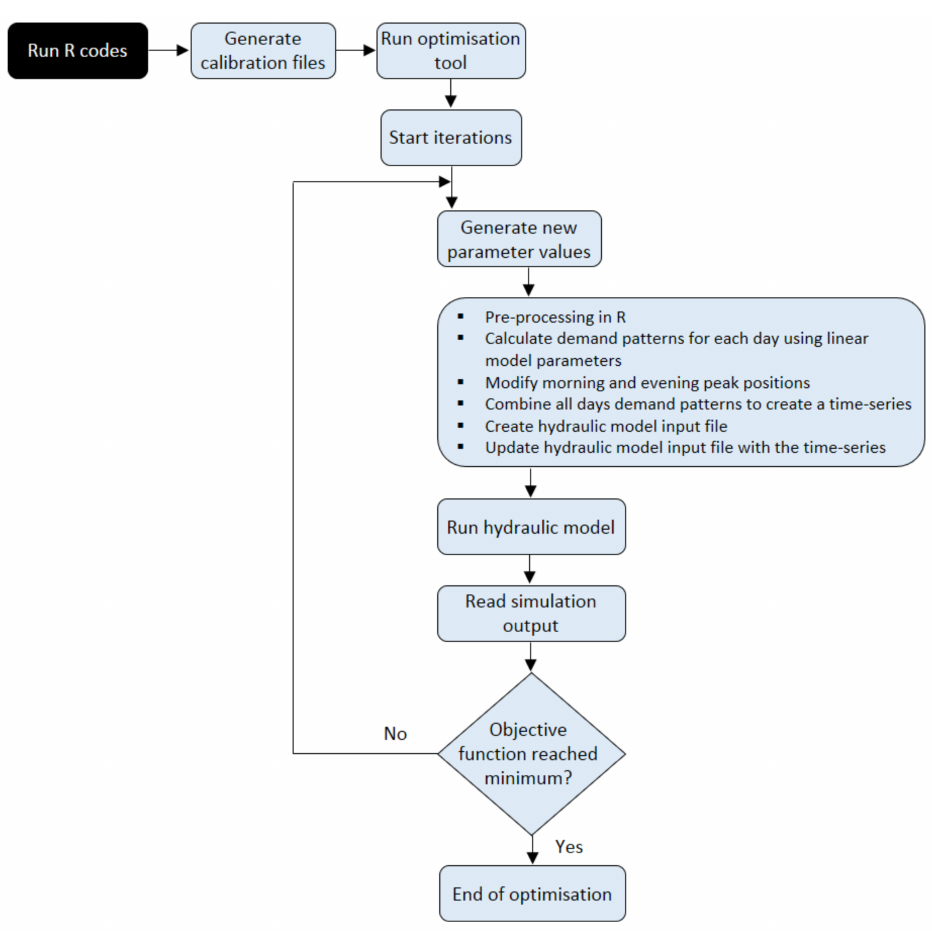
Figure 3. Flowchart of the calibration